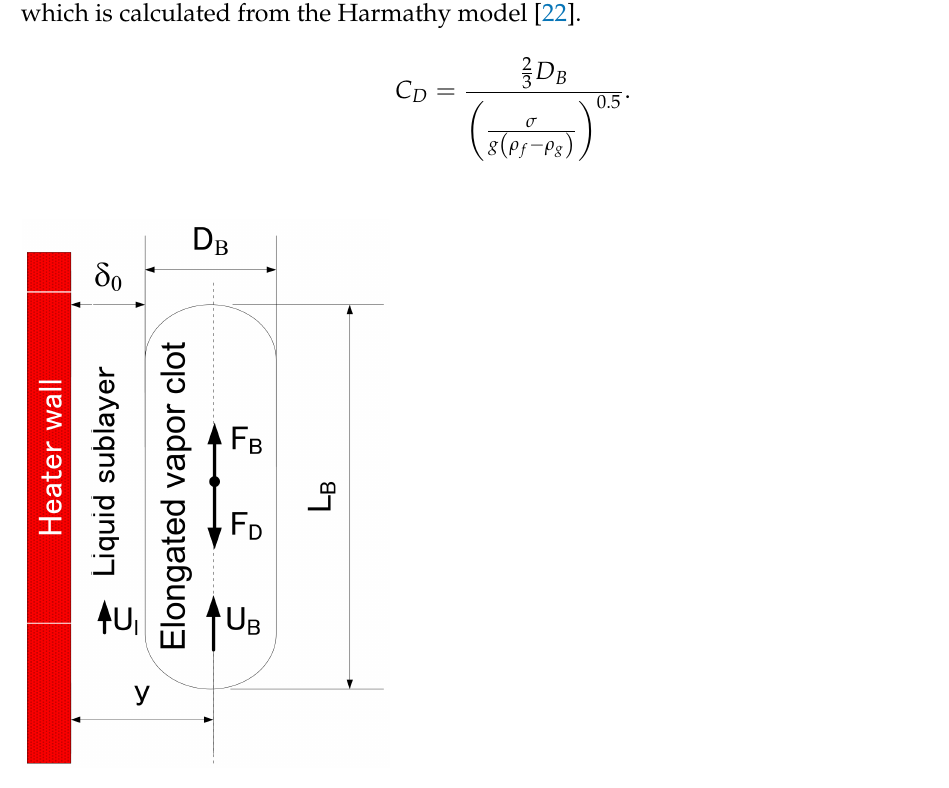
Figure 2. Relationship among y , D B , and δ 0